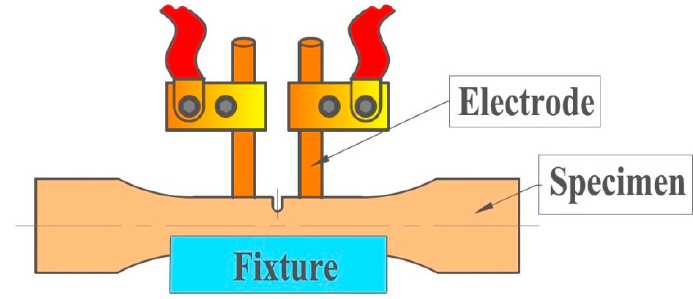
Figure 3. Settings for electropulsing treatment (EPT) of notched copper specimen.